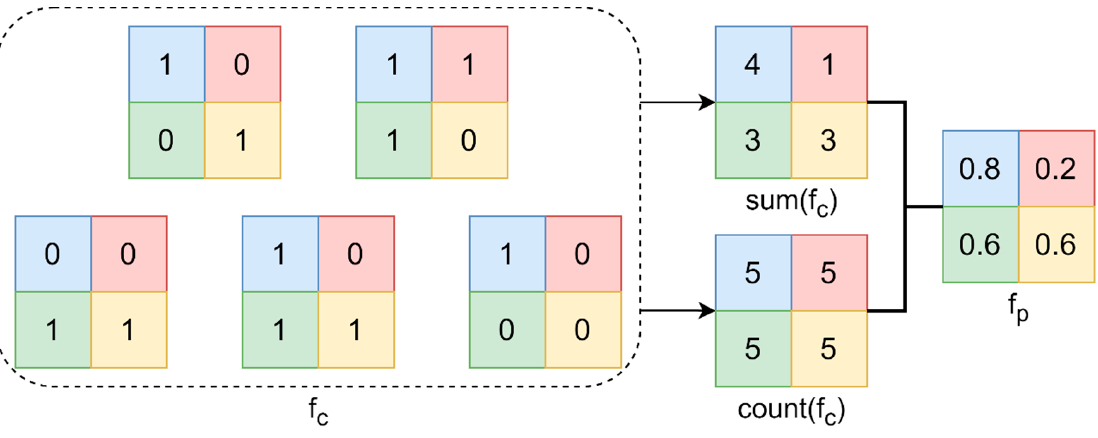
Figure 5. Probability feature value calculation.